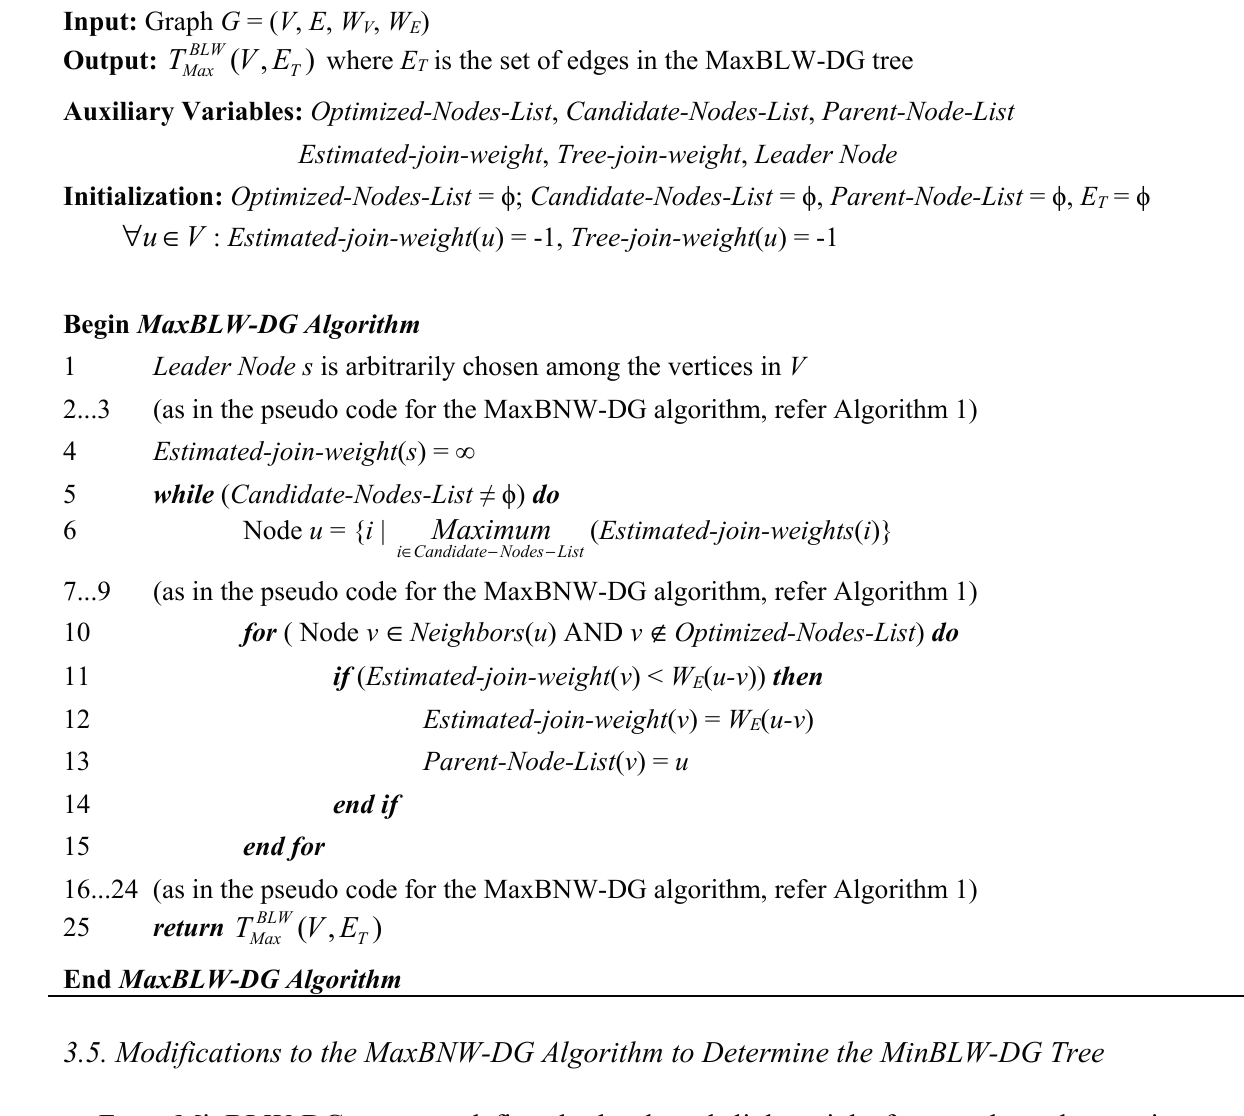
Algorithm 3. Pseudo Code for the Algorithm to Determine Maximum Bottleneck Link Weight-DG Trees.